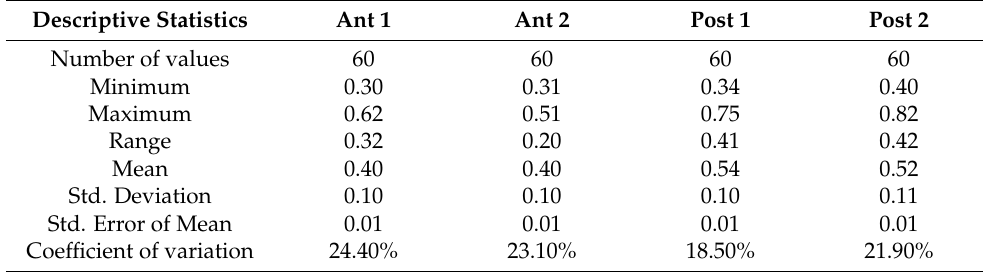
Table 2. Ultrasound thickness measurements of the superficial fascia of the